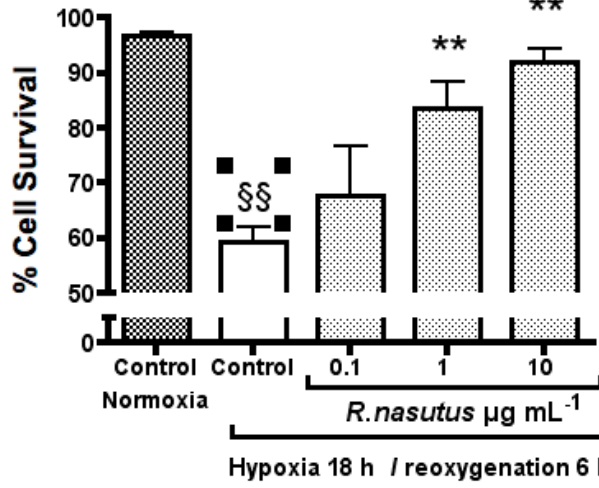
Figure 3. The protective effect of 24 h pretretment with R. nasutus against cell death caused by 18-hours hypoxia and 6-hours reoxygenation, measured using the Trypan blue exclusion assay. §§ One-way ANOVA Dunnett’s multiple comparison post hoc test normoxia control vs. hypoxia control P < 0.01. ** One-way ANOVA Dunnett’s